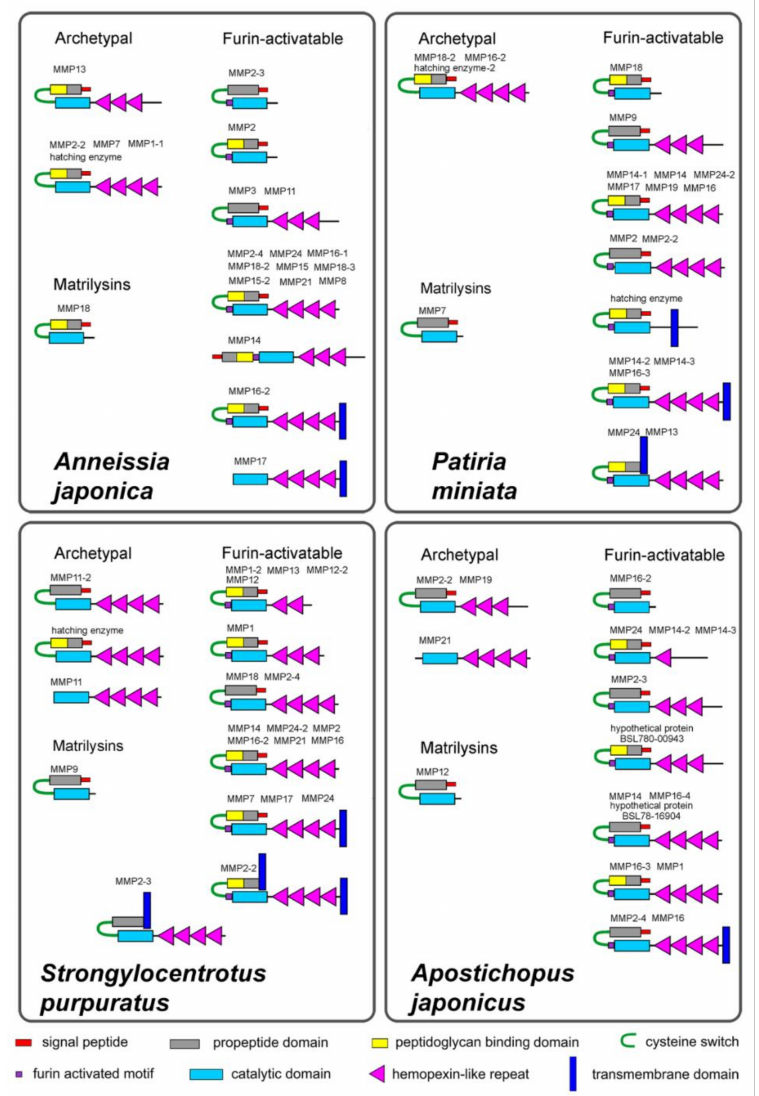
Figure 3. Scheme of structure of the matrix metalloproteinases of echinoderms. The domain structure was revealed using the Pfam (http://pfam.xfam.org/, accessed on 15 March 2021), Blast NCBI, and Smart (http://smart.embl-heidelberg.de/#, accessed on 15 March 2021) programs. In addition, SignalP-5.0 Server (http://www.cbs.dtu.dk/services/SignalP, accessed on 15 March 2021) and Phobius (https://phobius.sbc.su.se/index.html, accessed on 15 March 2021) were used to more accurately determine the presence of a signal peptide and transmembrane domains in a protein